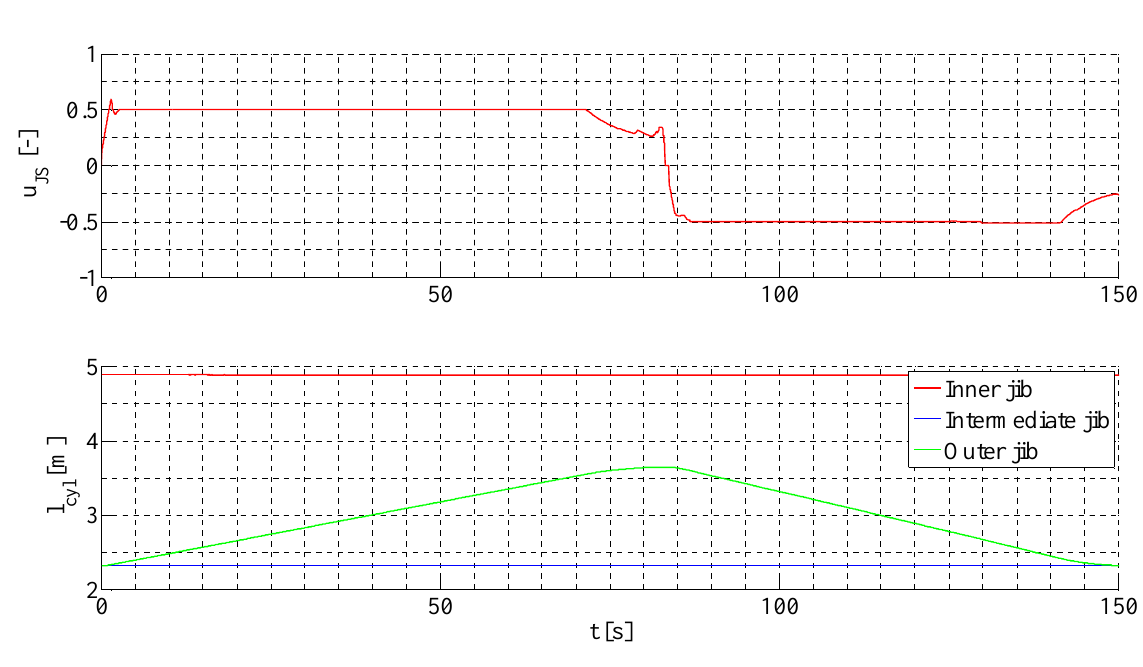
Figure 12: Experimental input and output for motion control sub-system for outer jib.